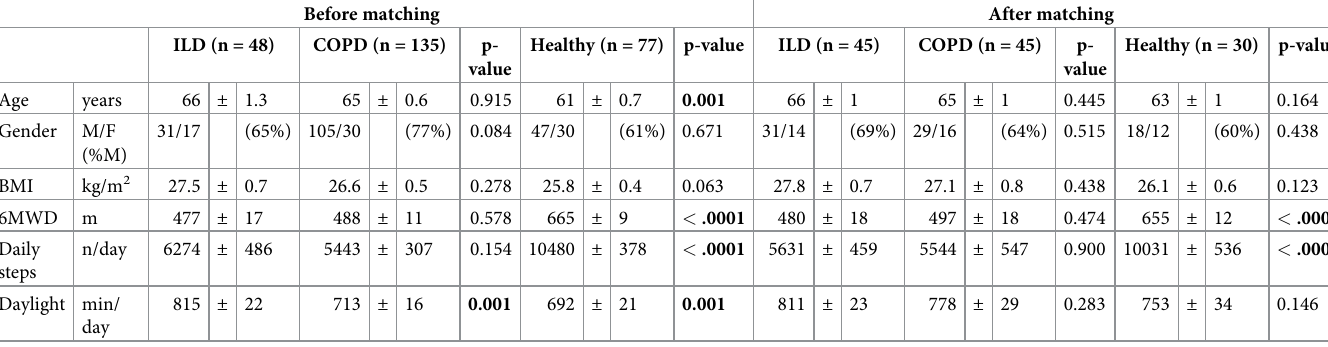
Table 1. Characteristics for ILD, COPD and healthy controls before and after propensity matching analysis. Before matching